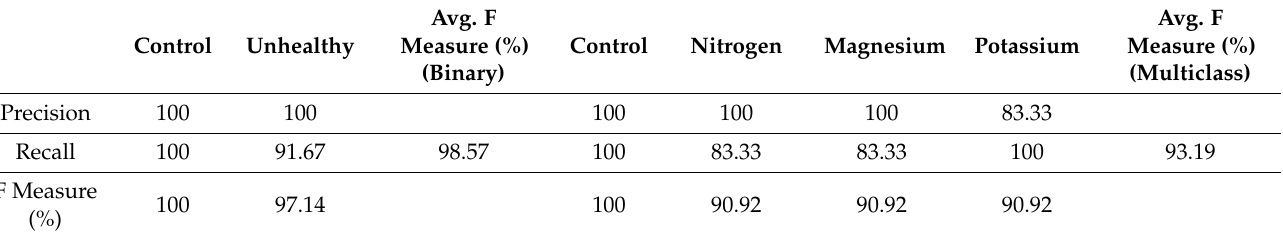
Table 3. Performance analasis using the SVM algorithm.